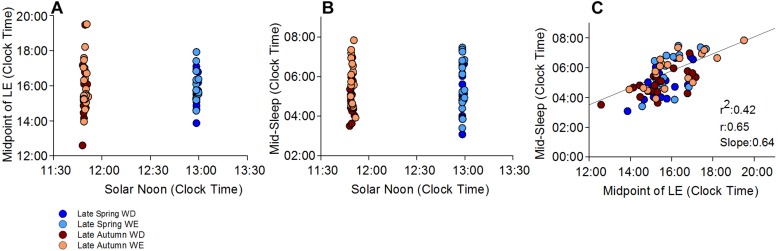
Midpoint of light exposure (50% LE) and mid-sleep time relative to SN and clock time. (A) shows individual 50% LE times relative to SN in late autumn and late spring. (B) shows individual mid-sleep times during weekends, weekdays in both seasons relative to the SN. (C) shows the relationship between 50% LE time and mid-sleep time, relative to clock time on averaged weekdays and weekends and in both seasons. Mid-sleep time is significantly correlated with the 50% LE exposure time, which explains 42% of the variance in mid-sleep time